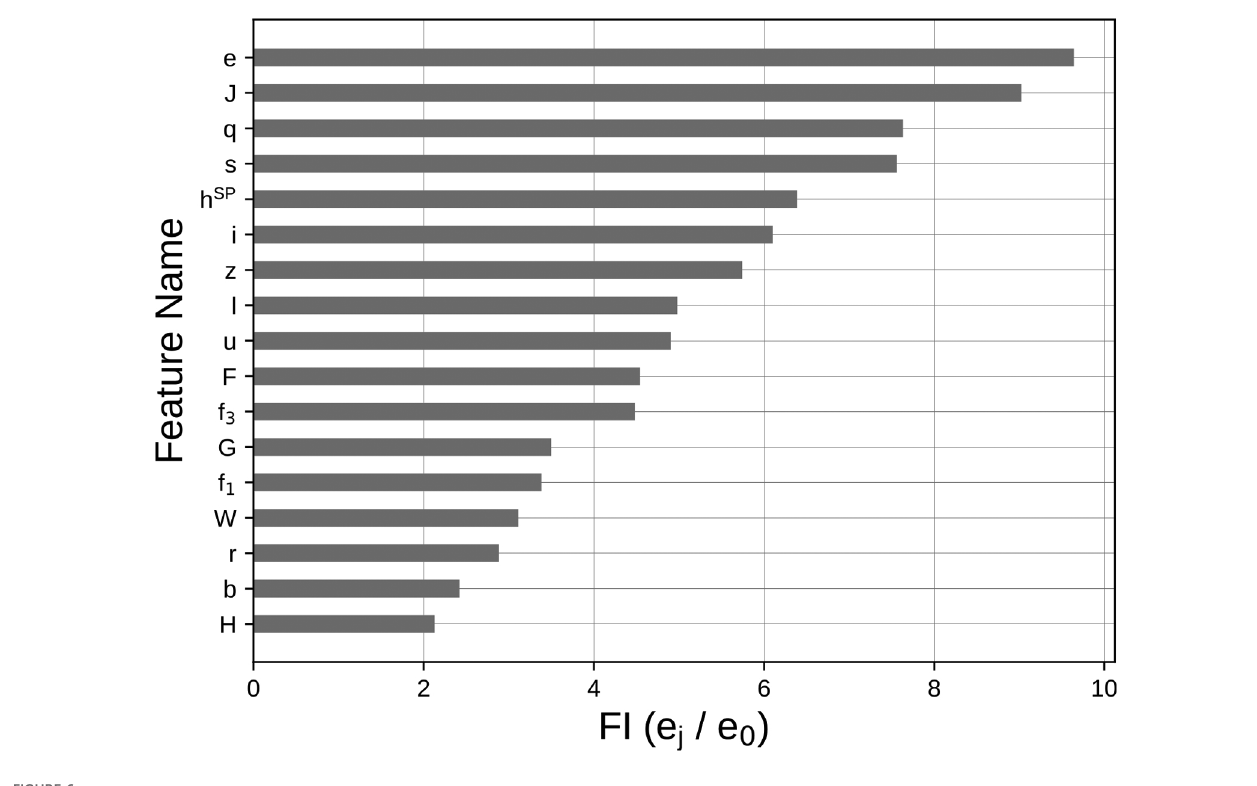
( Figure 5 ), as con fi rmed by Kendall ’ s Tau analysis ( t ¼ 0 : 38). On the contrary, there is no trend for MLP-estimates ( Figure 5 , t ¼ (cid:4) 0 : 02).